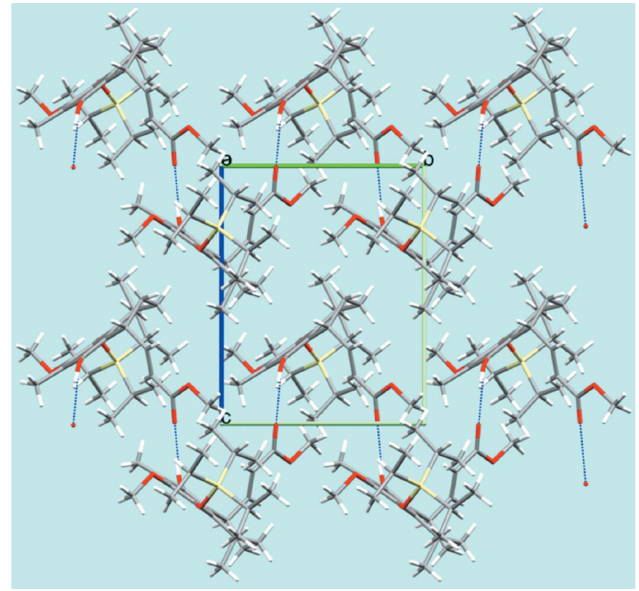
Figure 5 Molecular packing of ( 8 ) in the crystal structure, shown in a view along [100]. O (cid:2)(cid:2)(cid:2) H (cid:2)(cid:2)(cid:2) O hydrogen bonds are shown as blue dashed lines; C— H (cid:2)(cid:2)(cid:2) O hydrogen bonds are omitted for